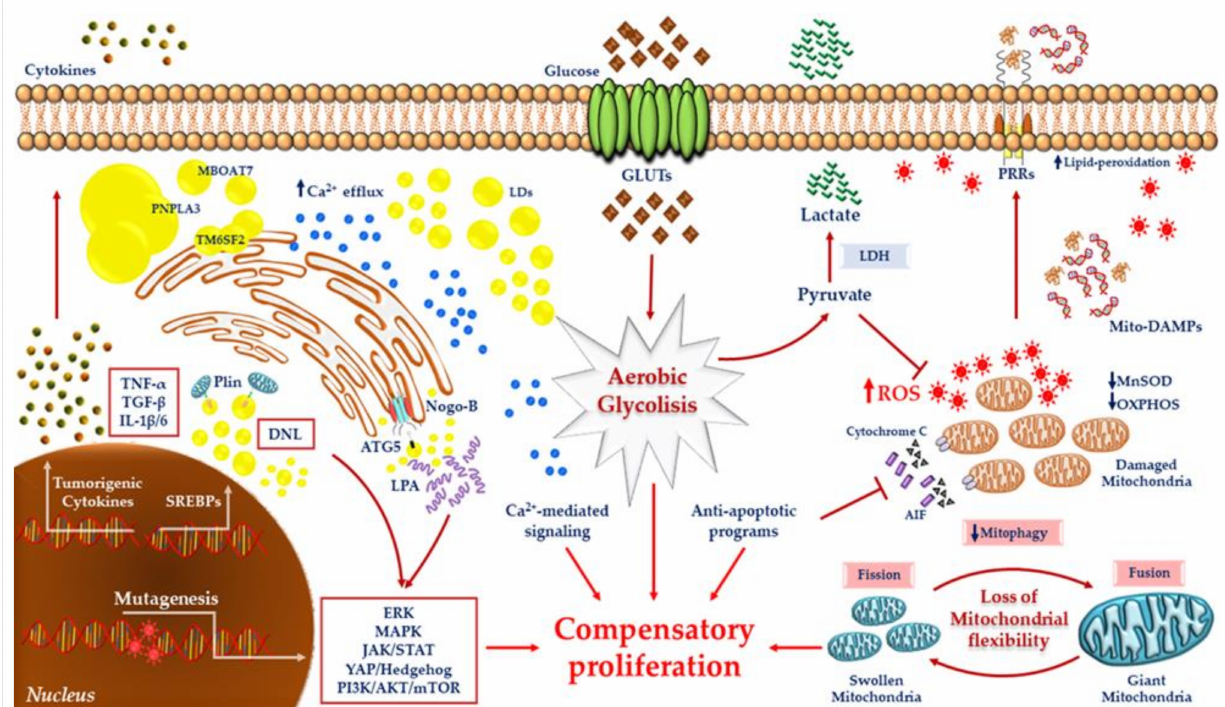
Figure 3. Mitochondrial pathways implicated in the pathogenesis of NASH-related HCC. Sedentary lifestyle, dietary habits and genetic background contribute to NAFLD development and its progression to NASH-driven HCC. The excess of hepatic fat accumulation promotes DNL, mitochondrial dysfunctions and the disruption of ER–mitochondrial contact sites. Consequently, the increased content of LDs may favor either lipotoxicity or energetic substrates for cell viability. The loss of mitochondrial flexibility and reduced mitophagy exacerbate the number of degenerated mitochondria, which produce ROS and release cytochrome C and AIF, thus activating apoptosis. The oxidative stress overwhelms antioxidant defenses, affects OXPHOS capacity, and triggers inflammatory signals (tumorigenic cytokines). In addition, ROS induce the mutagenesis of both nuclear DNA and mtDNA, causing the aberrant activation of proliferative pathways and the delivery of mito- DAMPs, respectively. Mito-Damps, including mitochondrial formyl-peptides and mtDNA fragments, could activate PRR receptors on the hepatocellular surface, KCs and HSCs, prompting inflammation and fibrosis. ROS-induced pro-survival signaling (i.e., JAK/STAT, ERK, MAPK) is able to counteract cell death by inducing the degradation of onco-suppressors and expanding the amount of hepatic progenitor cells. Moreover, the interruption of ER–mitochondria communication raises the efflux of cytosolic Ca 2+ , further contributing to ROS production and mutagenesis. Finally, hepatocytes undergo metabolic reprogramming, characterized by enhanced glucose uptake, high rates of glycolysis, and lactate production, which is rapidly secreted to avoid cytosolic acidification. Overall, a lipid-rich microenviroment combined with early loss of mitochondrial adaptability, both hallmarks of NAFLD onset and progression, may rearrange hepatocellular metabolism and the interplay between hepatocytes and non-parenchymal cells in order to overcome an adverse environment and trigger